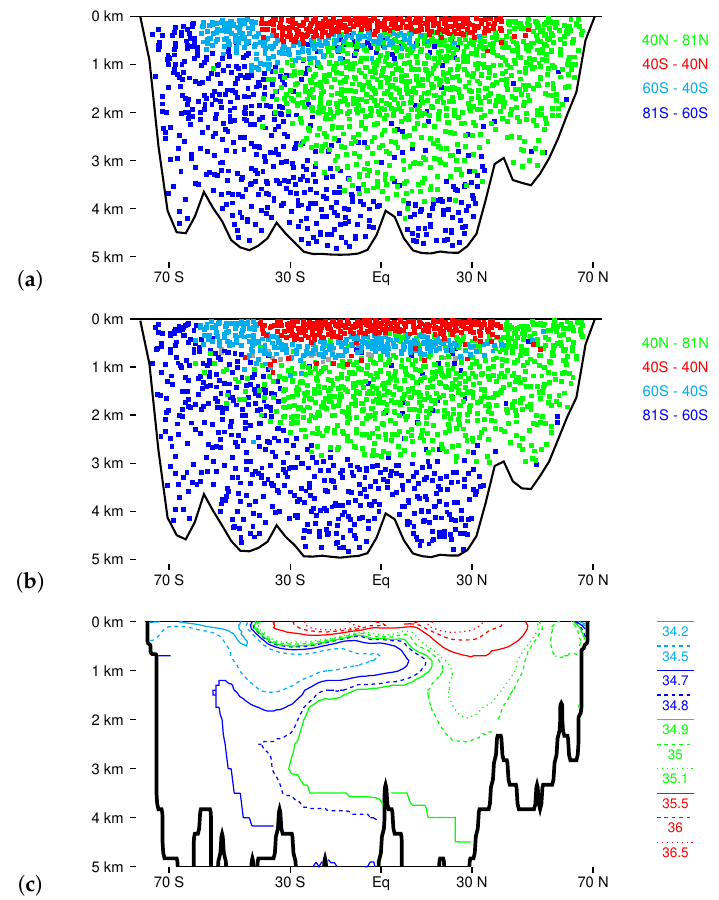
Figure 9. Water masses along 30 ◦ W. Parcels are color coded by the latitude of last surface contact in ( a ) the simulation with mixing. and ( b ) the simulation without mixing. ( c ) Observed water masses are inferred from the salinity